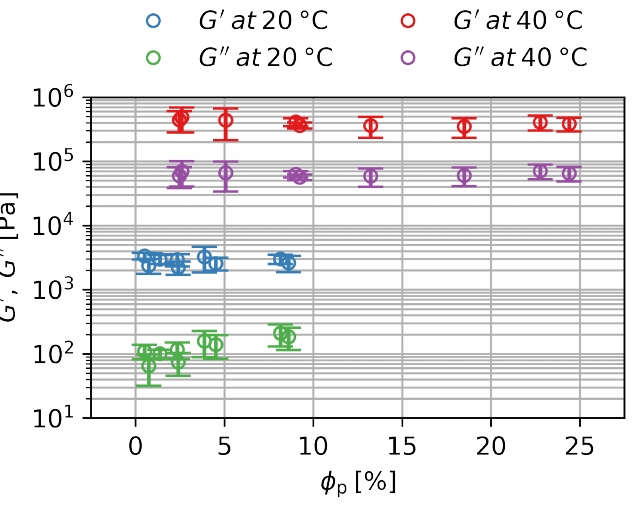
Figure 6. Storage and loss modulus over volume fraction of particles for the first and second batches. Averaged values for three samples per φ p with two standard deviations as statistical error are